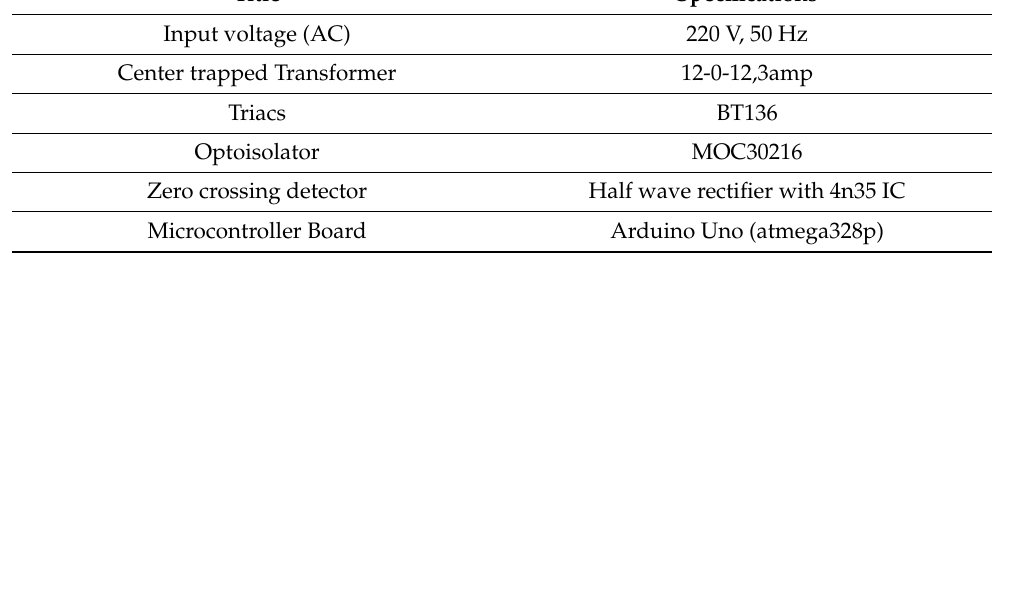
Figure 15. Physical experiment setup of the proposed cycloconverter controlling the voltage of re- sistive load. The results in Figure 16 show that the output voltage displayed by the Oscilloscope is the same as that of the expected results shown in Figure 4 and the simulation result in Figure 11.